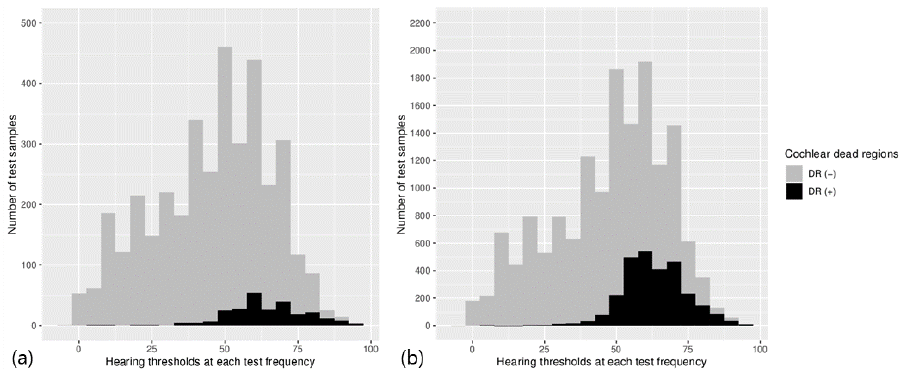
Figure 1. The distribution of cochlear dead regions according to the hearing thresholds at each